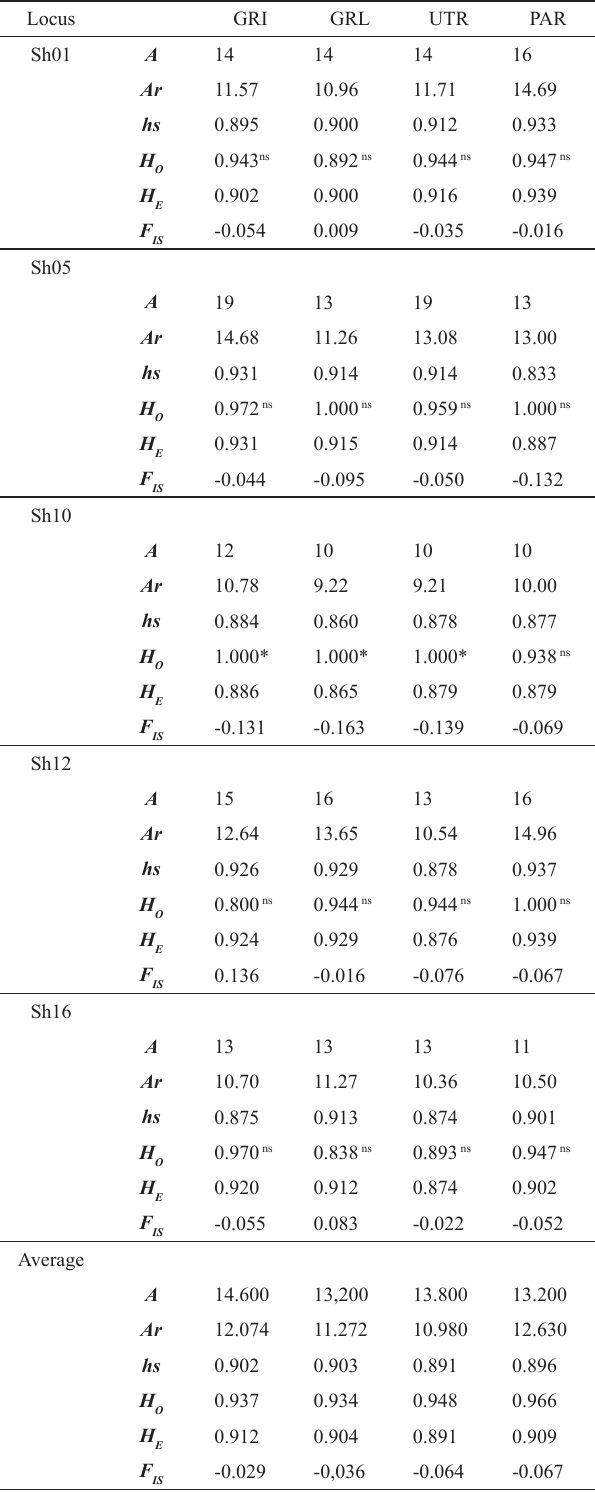
Table 1. Summary statistics for genetic diversity at five microsatellite loci of Salminus hilarii : ( A ) number of alleles; ( Ar ) allelic richness; ( hs ) Nei´s genetic diversity; ( Ho ) observed heterozygosity; ( H ) expected heterozygosity; ( F ) E IS inbreeding cœfficient. ns - Not significant, *Significant ( P < 0.0125) after Bonferroni adjustment (nominal α =